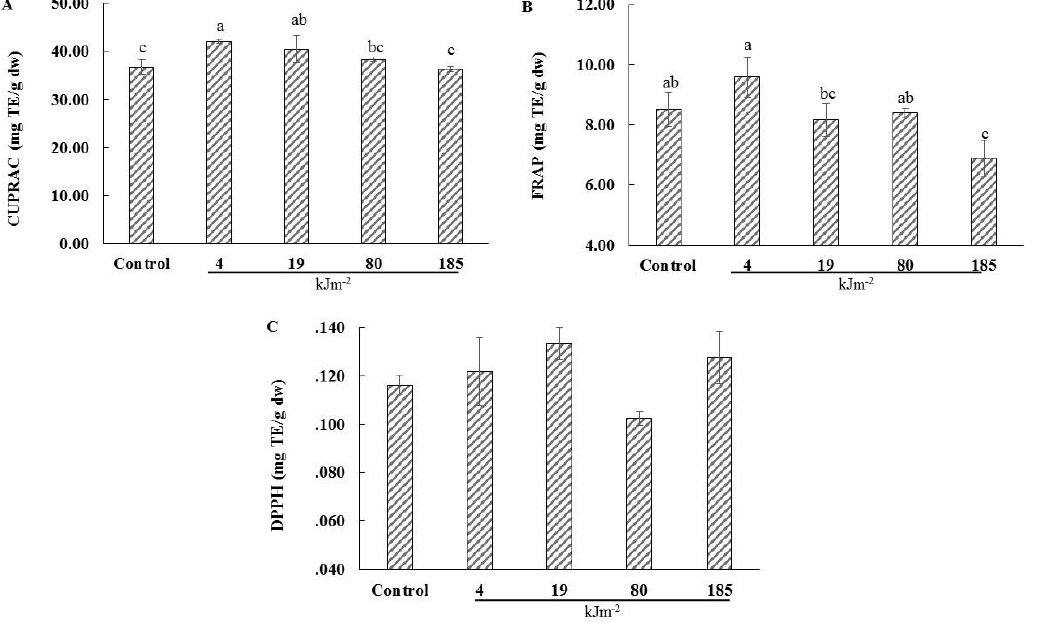
Figure 4. The Effect of different UV-C irradiations on the antioxidant capacity (Cupric reducing antioxidant capacity (CUPRAC) ( A ), Ferric reducing antioxidant power (FRAP) ( B ) and 2,2-diphenyl-1-picrylhydrazyl (DPPH) ( C )) of the aqueous lemon pomace extracts. The values are the mean of three replications. Data not sharing the same superscript letter are significantly different at p <